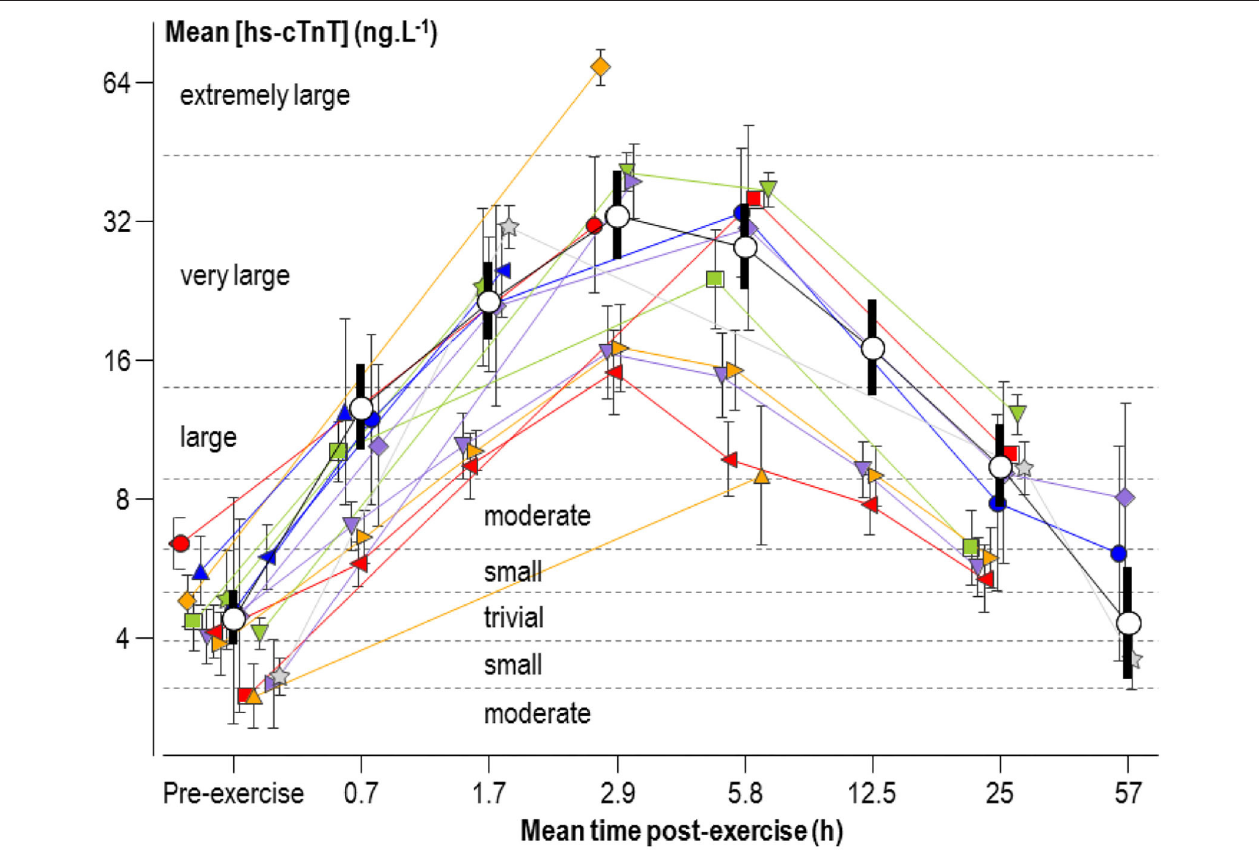
FIGURE 2 | Individual study-estimate and meta-analyzed predicted mean serum concentrations of high-sensitivity cardiac troponin T (hs-cTnT), plotted against the mean adjusted post-exercise time (post-exercise time plus half the duration of exercise). The meta-analyzed pre-exercise mean is for the average male athlete. The meta-analyzed post-exercise means are for the average male running for 2.5h with a mean heart rate of 155 min − 1 and a pre-exercise hs-cTnT of 4.4 ng L − 1 . Bars are 90% compatibility